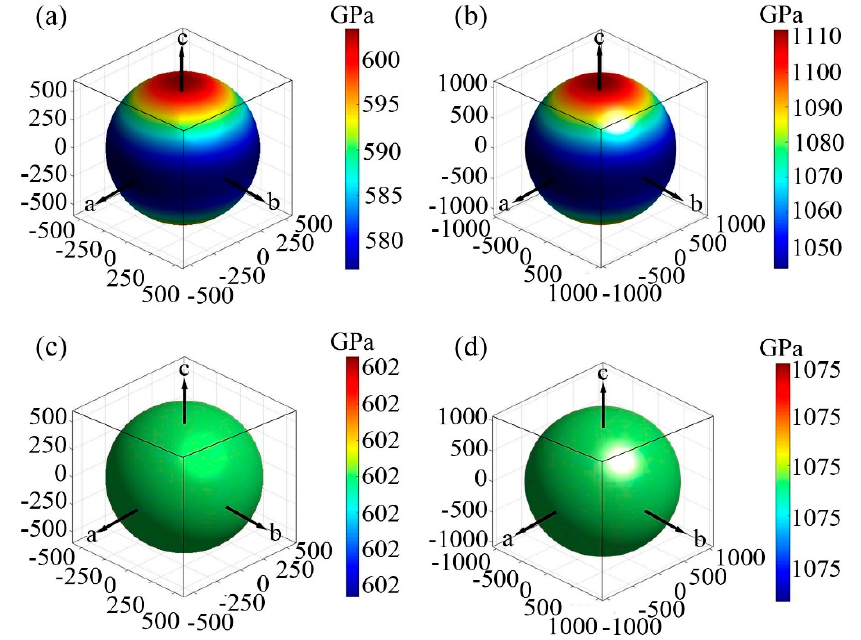
Figure 5. Direction dependences of the shear moduli of: ( a ) wurtzite GaN, 0 GPa; ( b ) wurtzite GaN, 40 GPa; ( c ) projections on main crystal planes, wurtzite GaN; ( d ) zinc-blende GaN, 0 GPa; ( e ) zinc-blende GaN, 40 GPa; ( f ) projections on main crystal planes, zinc-blende GaN.